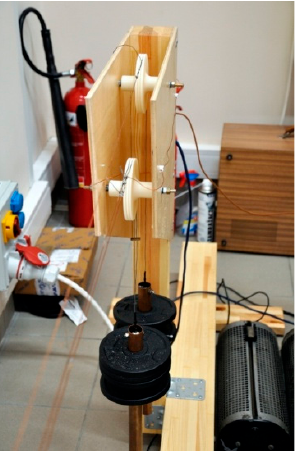
Figure 6. Terminal anchor pole with weight tensioner.